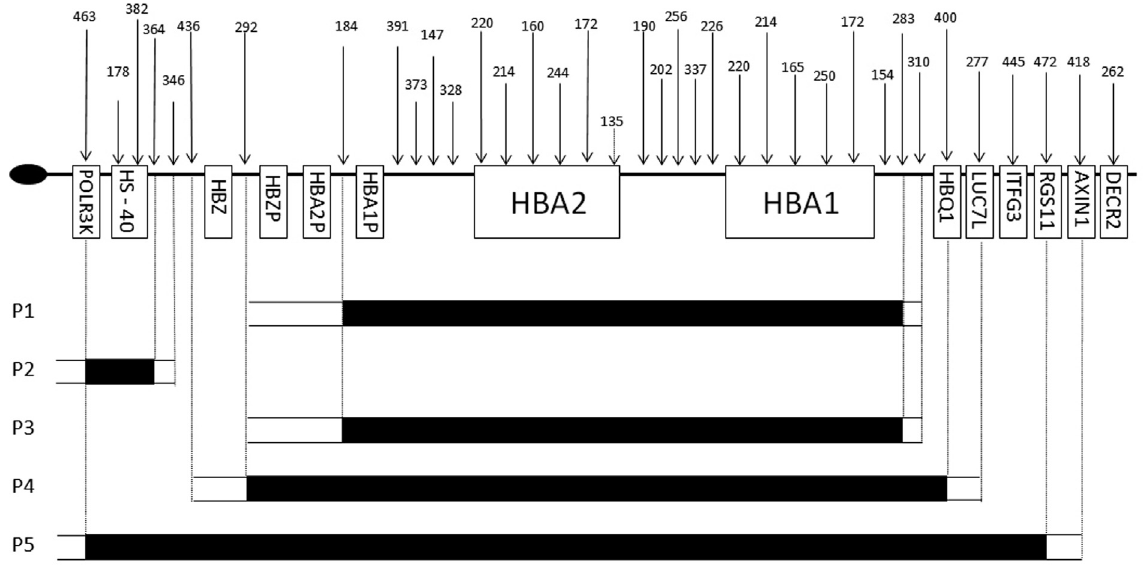
Figure 1 - Schematic representation of chromosome 16p13.3. The oval represents the telomeric region, the arrows the locations of the probes and the boxes the genes. The black bars correspond to the deleted fragments, the dotted lines denote the first and last deleted probes delimiting the segments con- taining the breakpoints (adapted from MRC-Holland, provider of the MLPA